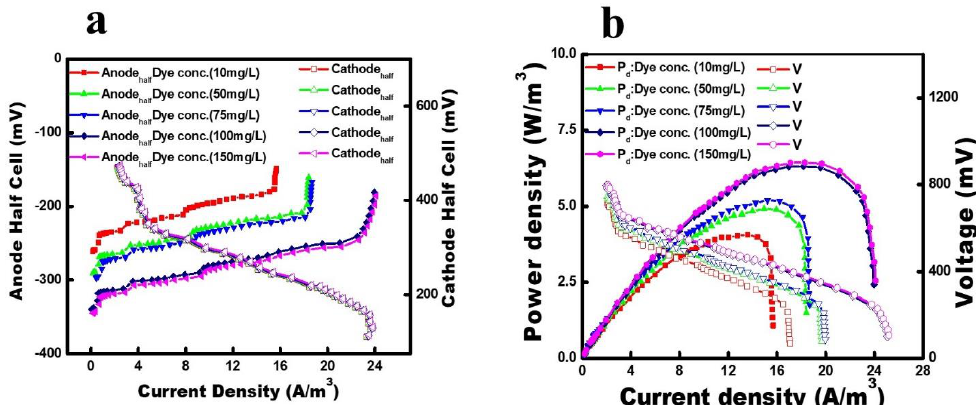
Figure 5. ( a ) Polarization curve of different MFCs with different concentrations of dyes (10, 50, 75, 100, and 150 mg/L) loaded on the anode and co-culture of bacteria. The data points for power density and voltage are represented by solid and open symbols on the graph; ( b ) Polarization plots of MFCs with different concentrations of dye (10, 50, 75, 100, and 150 mg/L)-loaded anodes and the co-culture of bacteria. The data points for power density and voltage are represented by solid and open symbols on the graph.